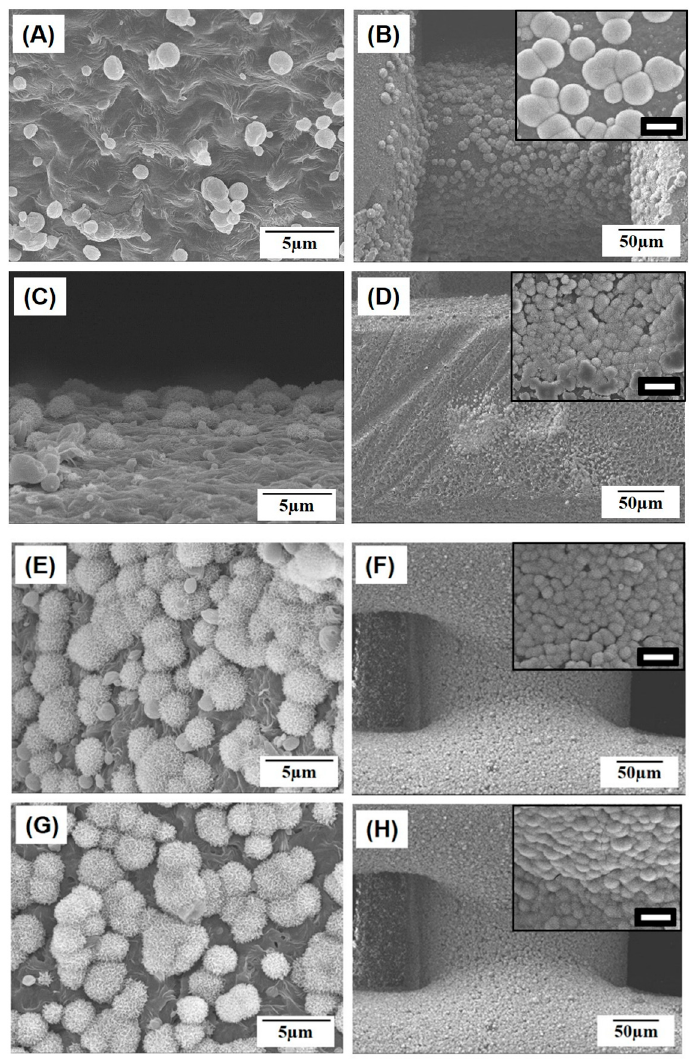
Figure 10. Representative SEM images of the macro/micro-porous PCL/HA composite scaffolds with various HA contents of 0 wt % ( A , B ); 10 wt % ( C , D ); 15 wt % ( E , F ); and 20 wt % ( G , H ) after soaking in an simulated body fluid (SBF) solution for 3 days ( A , C , E , G ) and 7 days ( B , D , F , H ). (Scale in insets = 20 µm). Insets show the high-magnification SEM images of the struts.